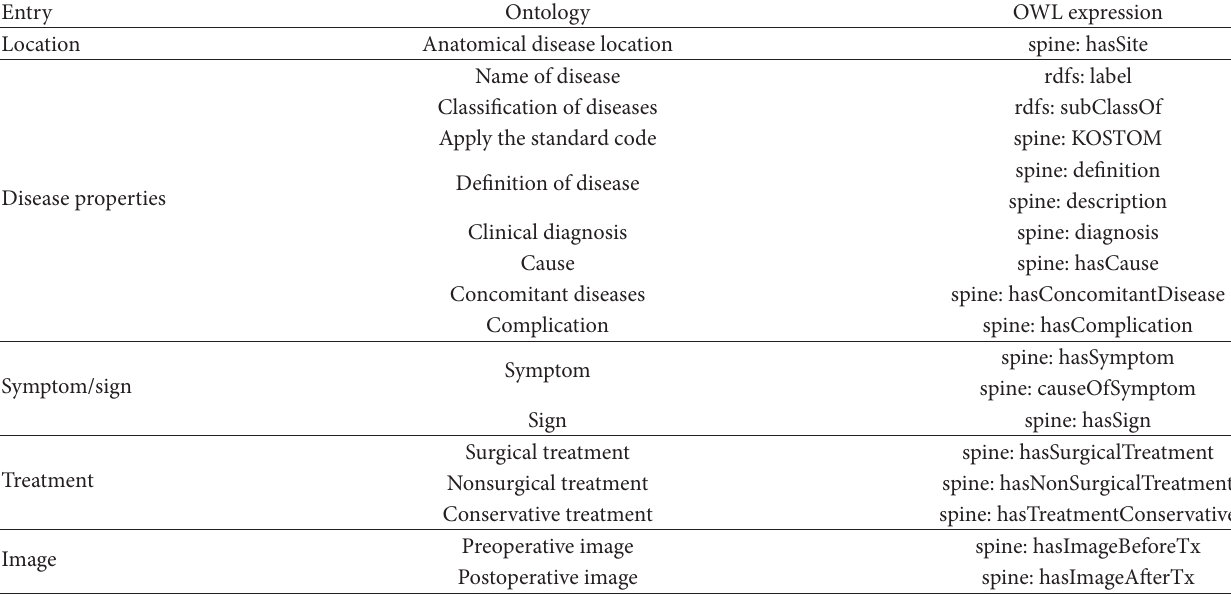
Table 2: Diseases related information represented in ontology.